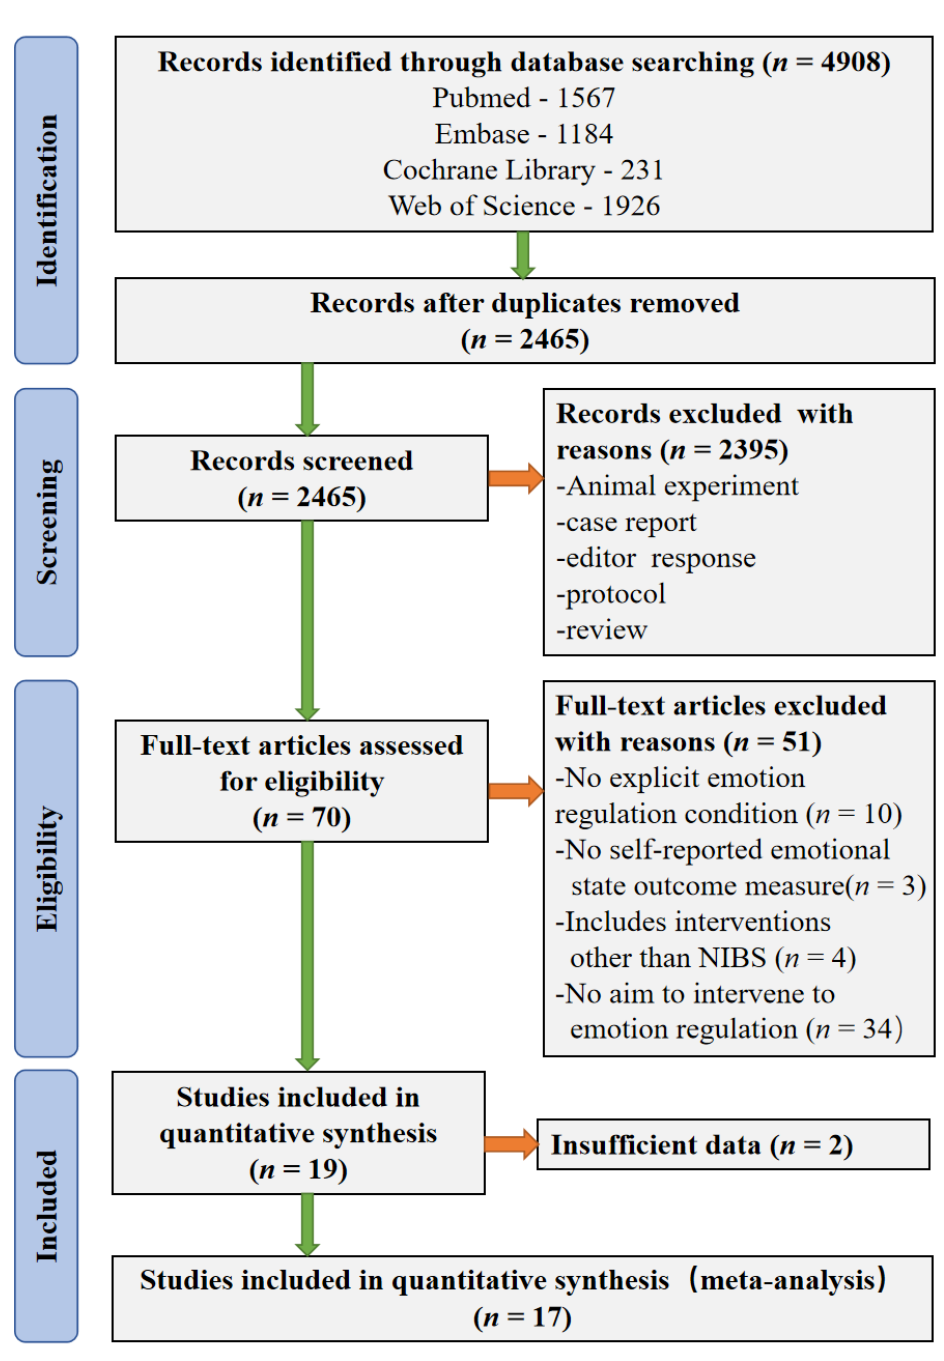
Figure 1. PRISMA flow diagram of literature search and study selection.